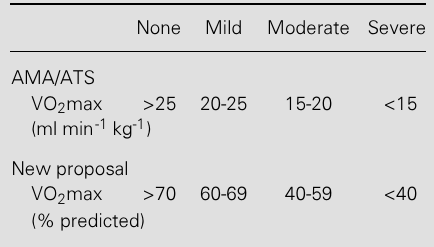
Table 1 - Aerobic dysfunction according to a classi- fication for rating remaining ability (AMA/ATS) and a new proposal for rating loss of